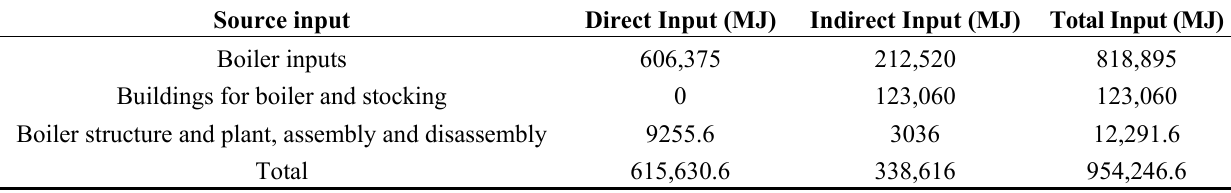
Table 9. Energetic inputs of boiler, total productive cycle (10